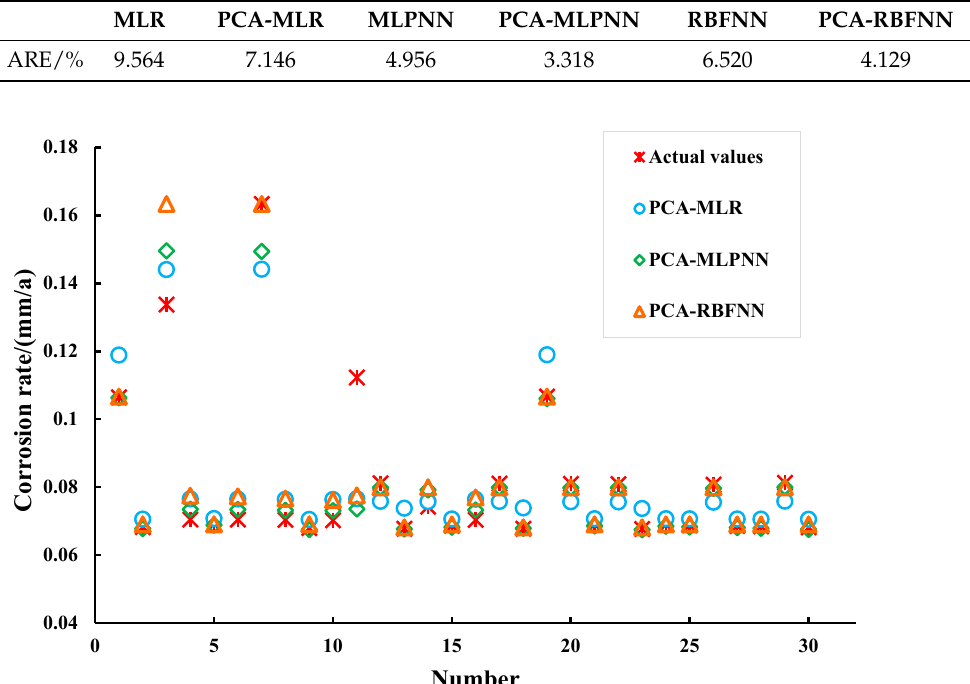
Figure 6. Comparison of model relative errors.